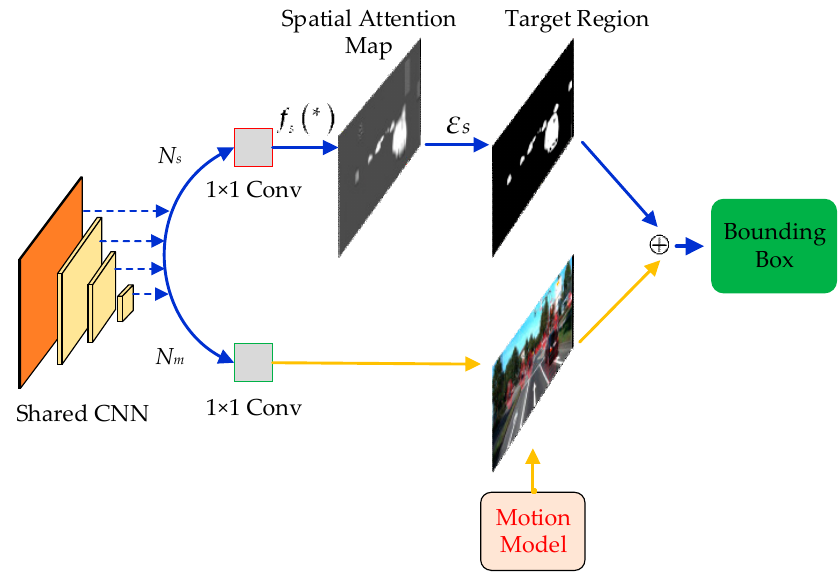
Figure 3. Offline Candidates Recommendation Module. Figure 3. O ffl ine Candidates Recommendation